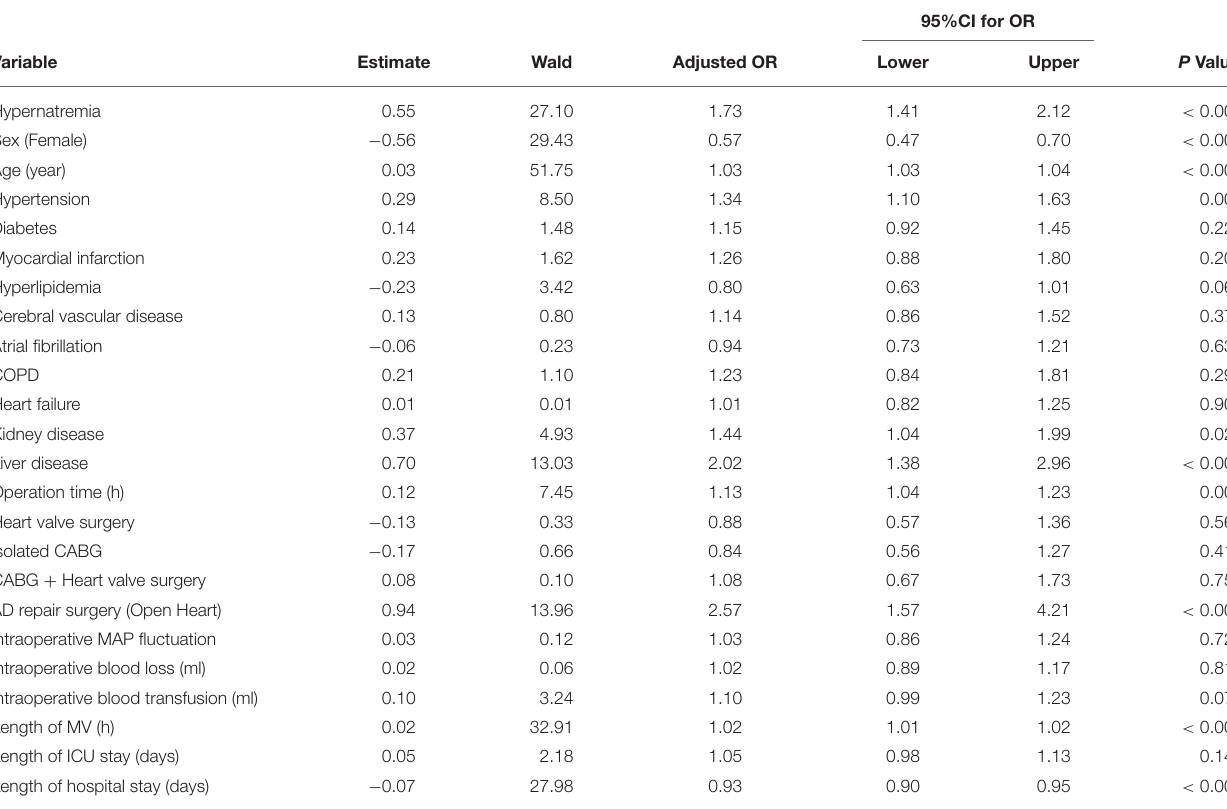
TABLE 3 | Association between hypernatremia exposure and delirium after cardiac surgery.